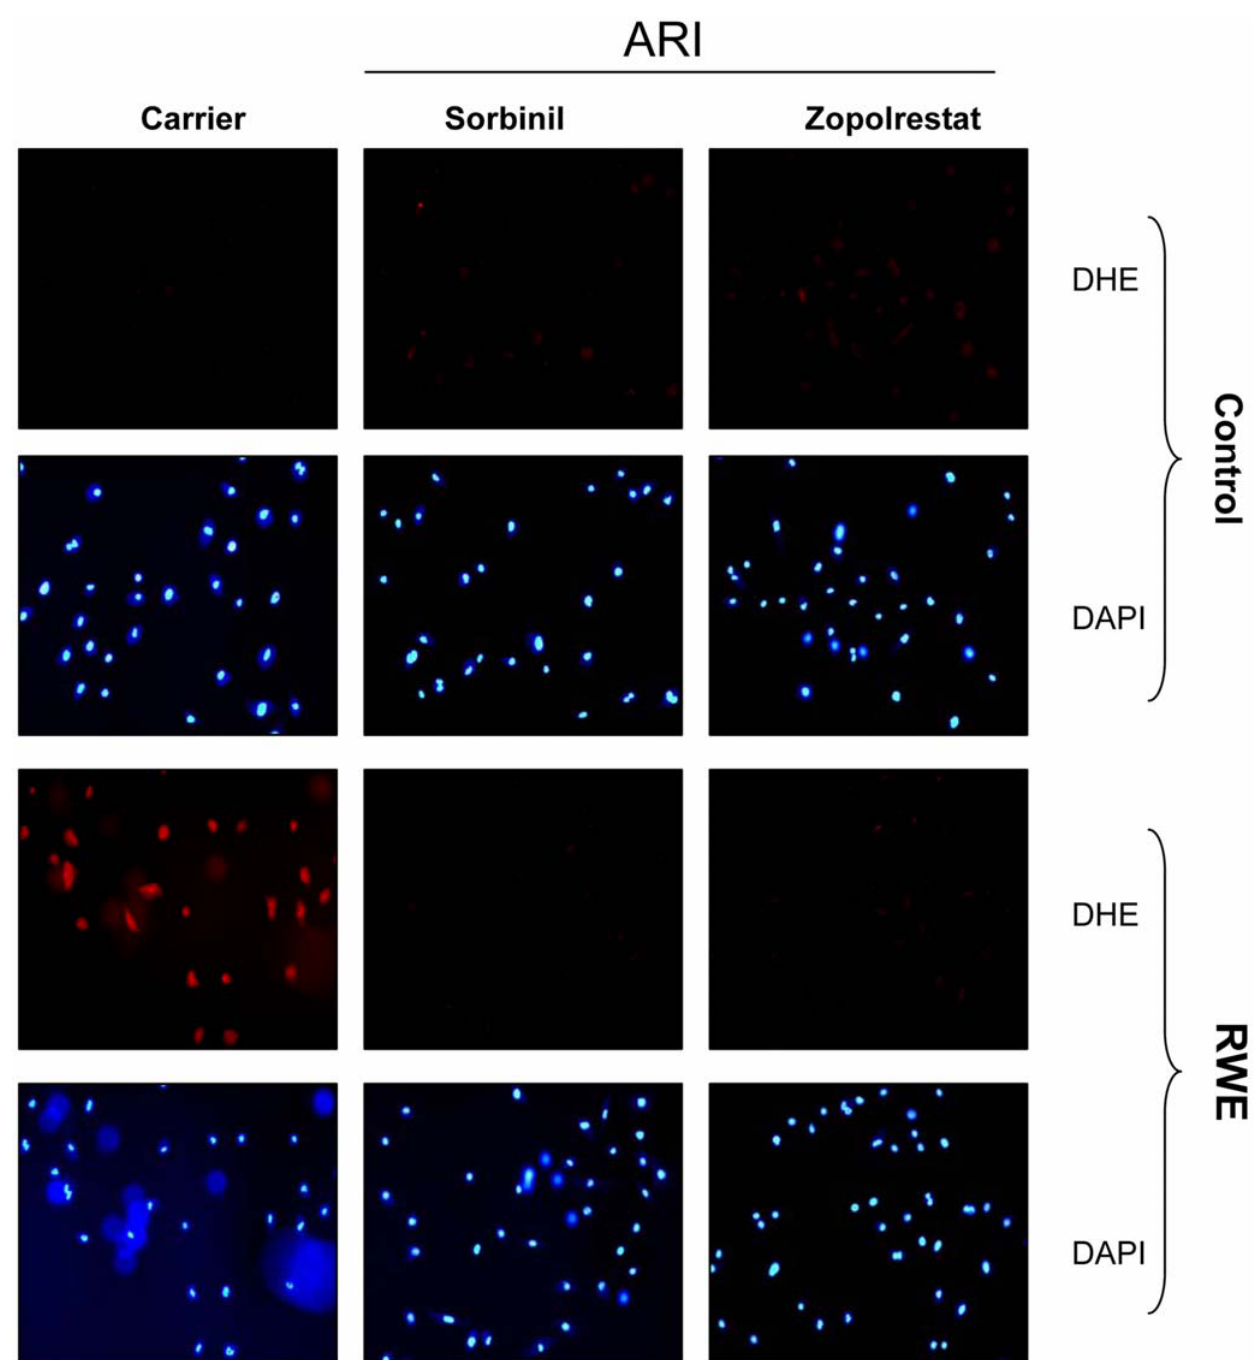
Figure 2. Inhibition of AR prevents RWE-induced ROS generation in SAEC. Approximately 1 6 10 5 cells were seeded on 2-chambered slides and starved in serum-free basal medium with or without AR inhibitors, sorbinil or zopolrestat, for 24 h. The cells were treated with RWE (150 m g/ml) for 16 h. The SAEC were washed with cold PBS (pH 7.2) and stained with ROS-sensitive dye, dihydroethidium (DHE) for 15 min at 37 u C. The cells were washed again and mounted with floursave (with diamidino-2-phenylindole (DAPI)) mounting medium. Photomicrographs were acquired by a fluorescence microscope (Nikon). A representative picture is given (n=4); Magnification 200 6 . ARI, aldose reducatse inhibitor. doi:10.1371/journal.pone.0006535.g002 of SAEC with AR inhibitor, zopolrestat, significantly ( . 90%) prevented the increase. This indicates that RWE-induced COX-2 and iNOS overexpression is mediated by AR, which is obligatory for RWE-induced PGE 2 and NO production that exacerbate allergic inflammation.